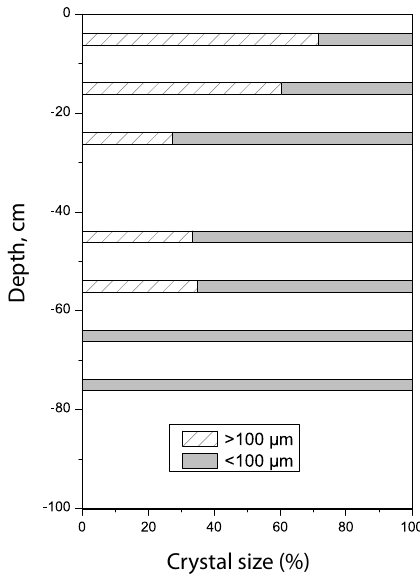
Fig. 4. Vertical distribution of small ( < 100µm) and large ( > 100µm) ikaite crystals in the sea ice.